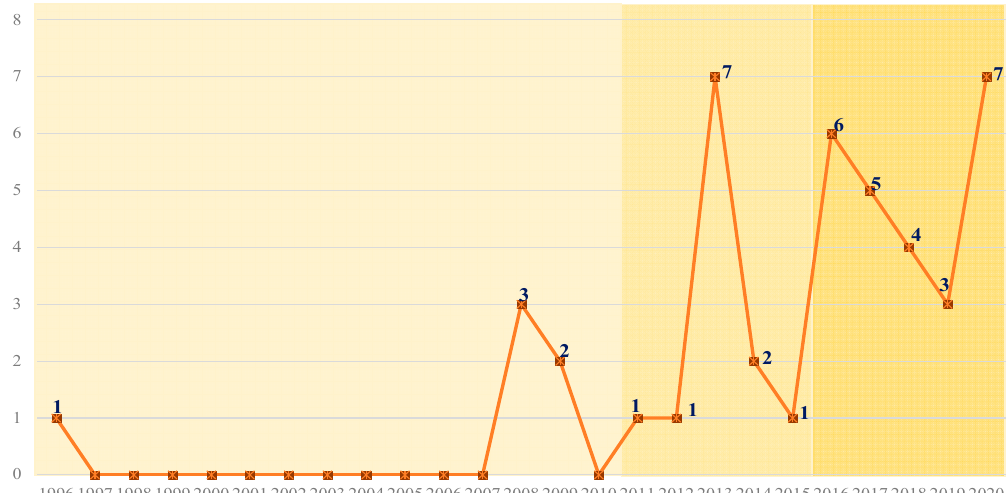
Figure 3. Published literature on AI in mathematics education from 1996 to 2020.